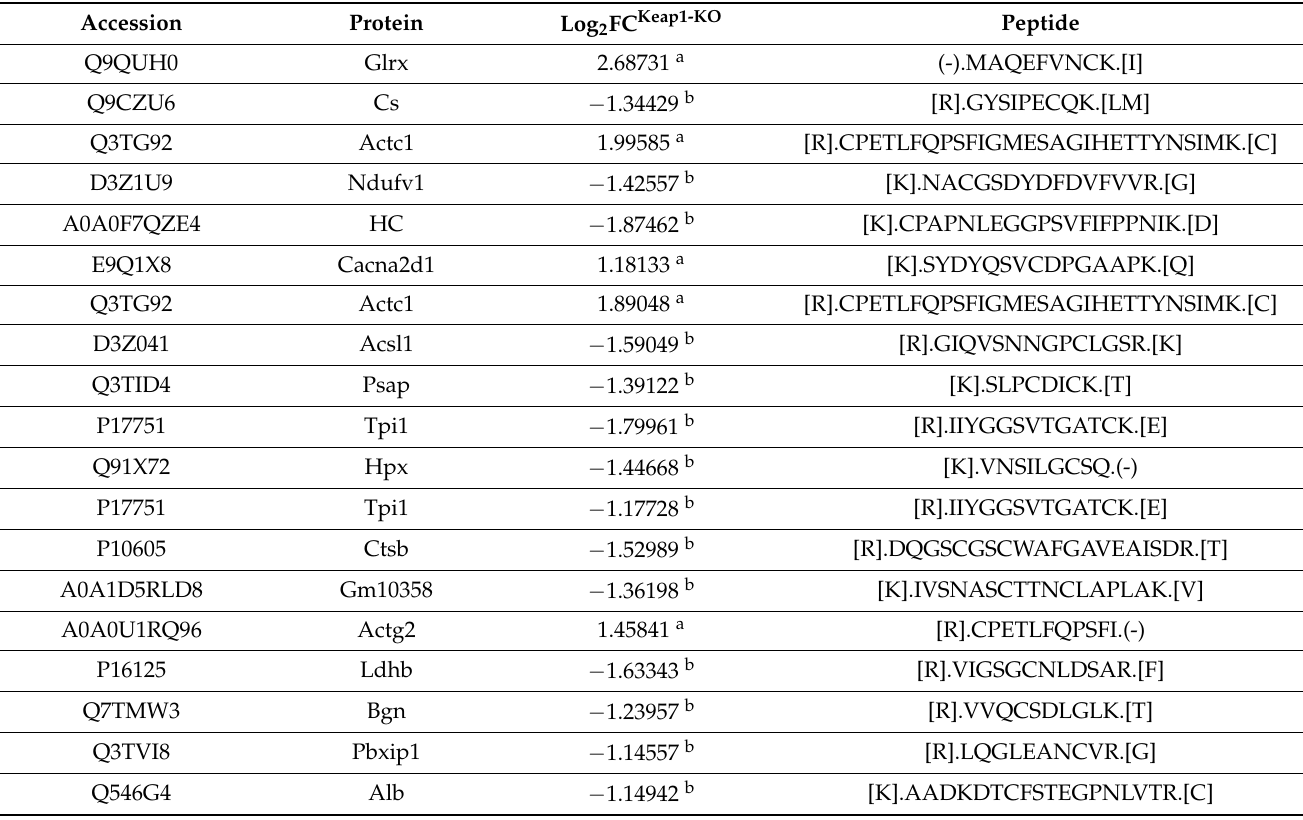
Table 3. List of significantly differentially expressed redox peptides in Keap1-KO-deficient